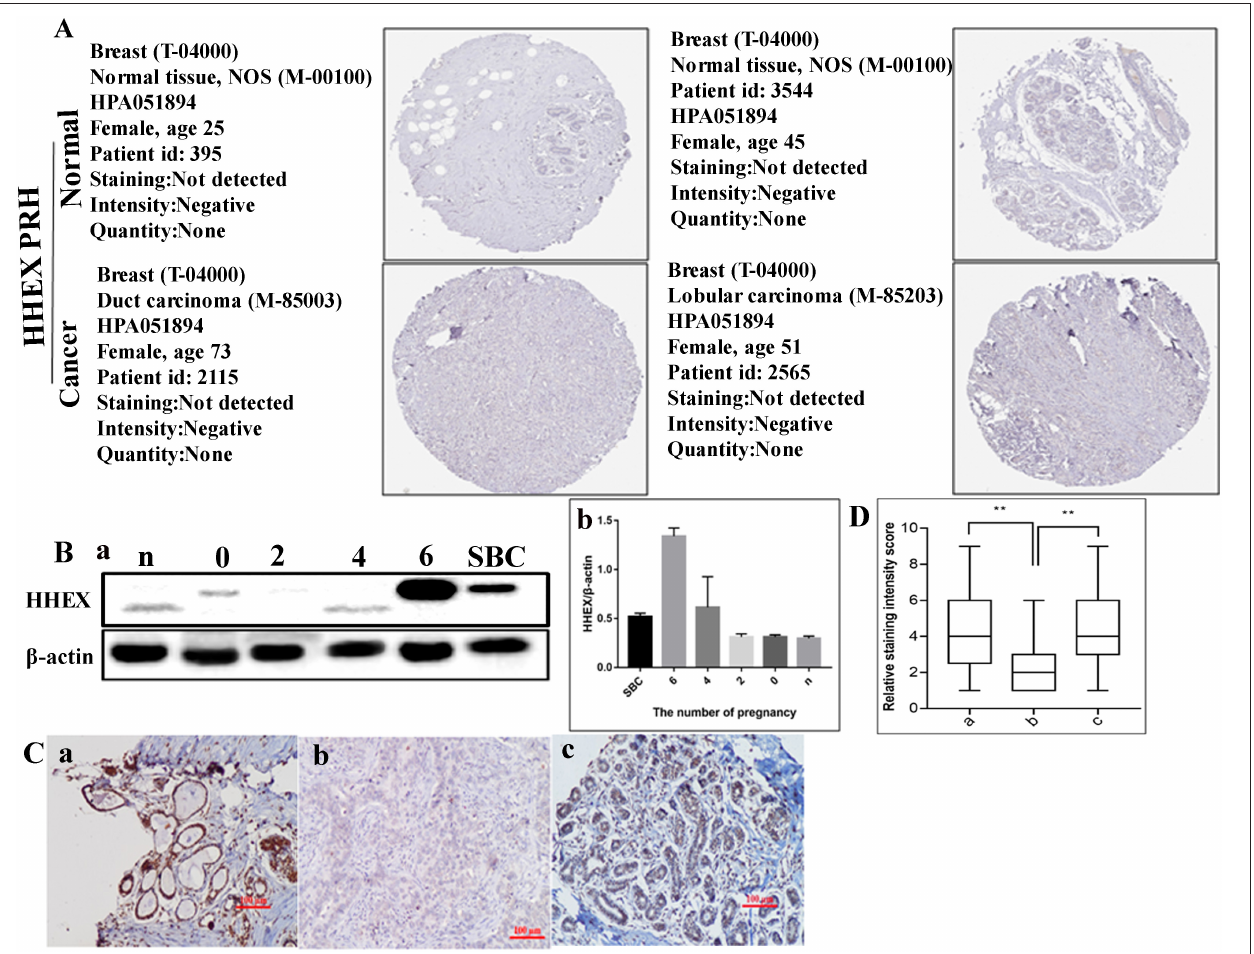
FIGURE 2 | HHEX expression in human breast cancer (BC) tissues. (A) HHEX protein expression in BC tissues determined using HPA. (B) Expression levels of HHEX. (a) Expression levels of HHEX by western blot analysis in TA2 mice with different numbers of pregnancies and SBC. (b) Histogram shows the quantitative results of the HHEX expression in breast tissue TA2 mice with different numbers of pregnancies and SBC. (C) Immunohistochemical (IHC) staining of HHEX expression in human breast tumors (200 × ). (a–c) HHEX expression in group I–III, respectively. (D) Interquartile spacing diagram showing the quantitative results of the HHEX expression in the three groups. a: precancerous lesions; b: breast cancer; c: benign breast tumors. n, breast tissues of virgin TA2 mice; 0, breast tissues of TA2 mice without pregnancy; 2, breast tissues of TA2 mice with 2 pregnancies; 4, breast tissues of TA2 mice with 4 pregnancies; 6, breast tissues of TA2 mice with 6 pregnancies;. SBC, spontaneous breast cancer. Statistically significant differences are indicated: ** P < 0.001.